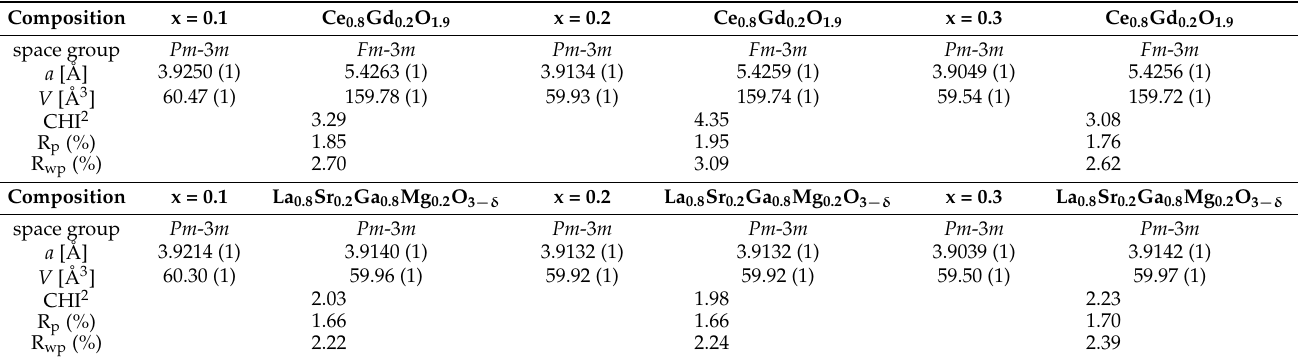
Table 4. Structural parameters of Sr 2 Fe 1 . 4 Ti x Mo 0 . 6 − x O 6 −δ (x = 0.1, 0.2 and 0.3) oxides with Ce 0 . 8 Gd 0 . 2 O 1 . 9 and with La 0 . 8 Sr 0 . 2 Ga 0 . 8 Mg 0 . 2 O 3 − d electrolytes from 50:50 wt.% mixtures fired in air for 10h at 1200 °C.